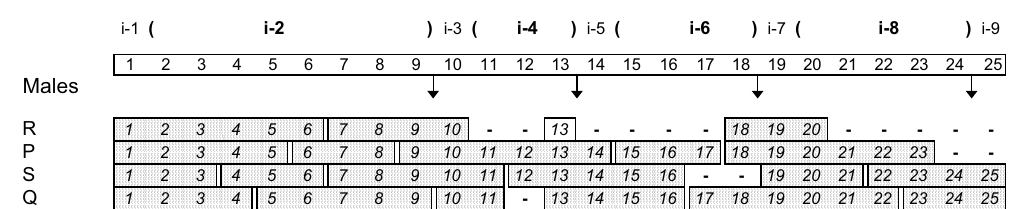
Fig. 7 – Imitations (italic numbers) and their sequential associations (song-packages, stippled areas) developed by the birds P-S from strings presented in the experiment ‘pattern cueing’. Symbols of master song-types are given on top. The arrows indicate the sequential locations where a group of song-types which shared initial song sections ended, and where package boundaries were expected if cueing occurred. Acquisition failures are given by ‘–’.